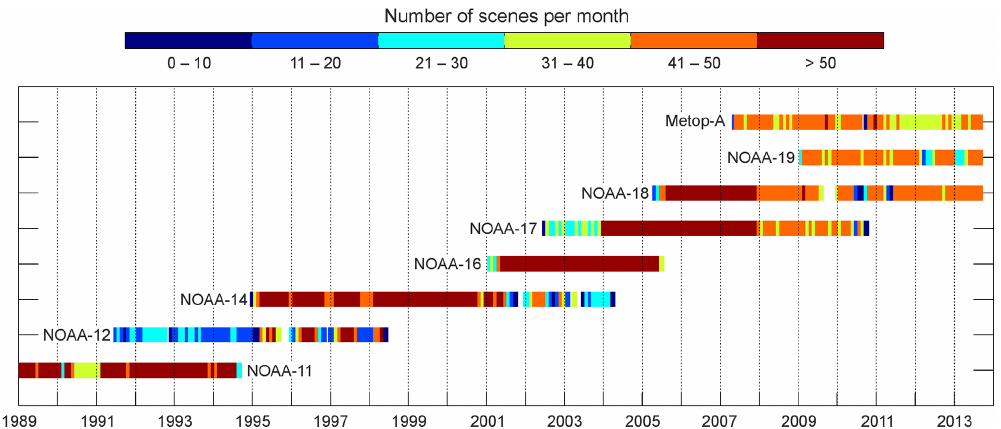
Figure 2. Number of available satellite overpasses per satellite and month for the period between 1989 and 2013. Shown are all NOAA satellites from NOAA-11 to NOAA-19 and MetOp-A. Due to quality issues, NOAA-15 data has been excluded. MetOp-B data is also not included in the current version of the data set, since it has only been launched in September 2012. Further data (as of 1984 and for the whole of Europe) are available in the archive of the Remote Sensing Research Group at the University of Bern, which are currently being prepared in an ongoing